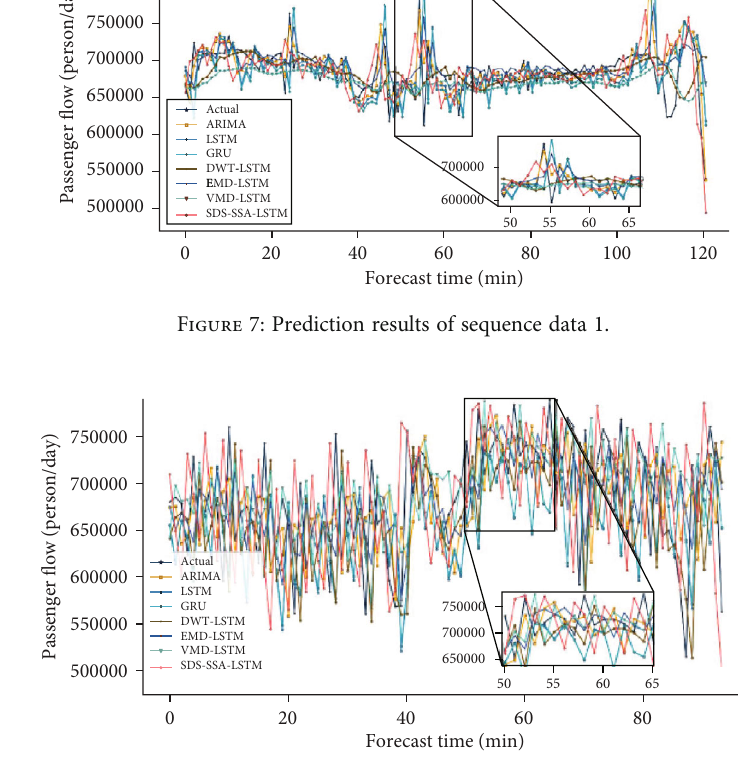
Figure 8: Prediction results of sequence data 2. Table 2: Comparison of model prediction